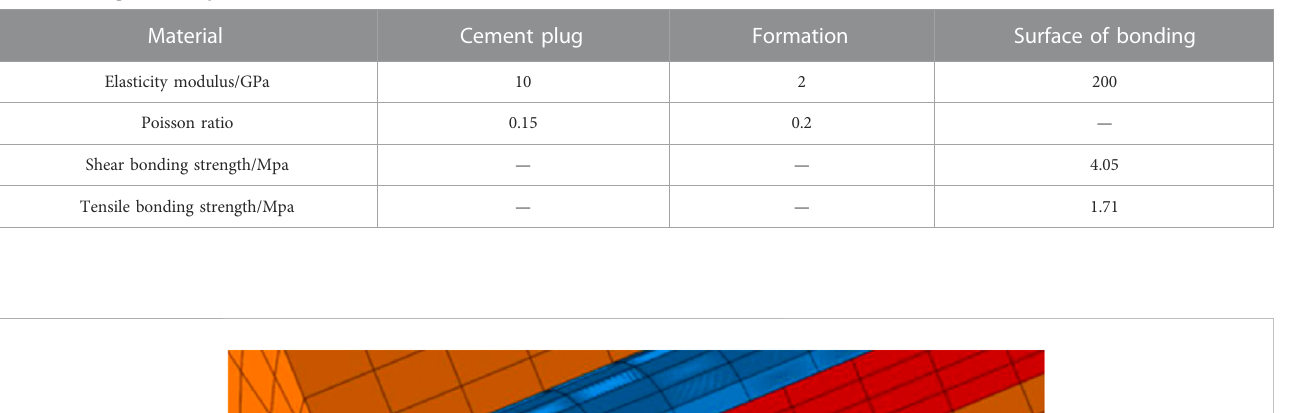
TABLE 1 Setting of model parameters.